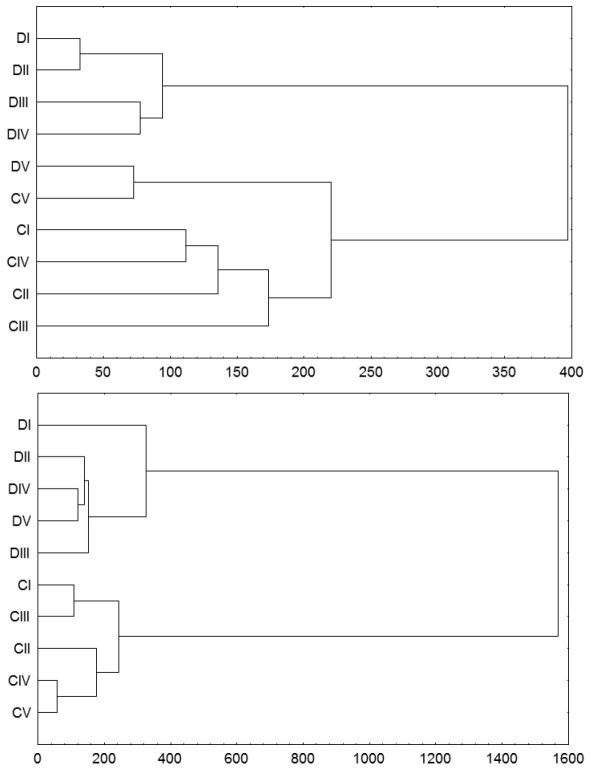
Dendrograms of species similarity of carabid beetle assemblages inhabiting tornado-impacted (D) and control stands (C) in age classes I–V (see text) in the first (2003) and last (2008) years of observation. The analysis was performed with the Ward method and Euclidean distance as the measure of similarity.